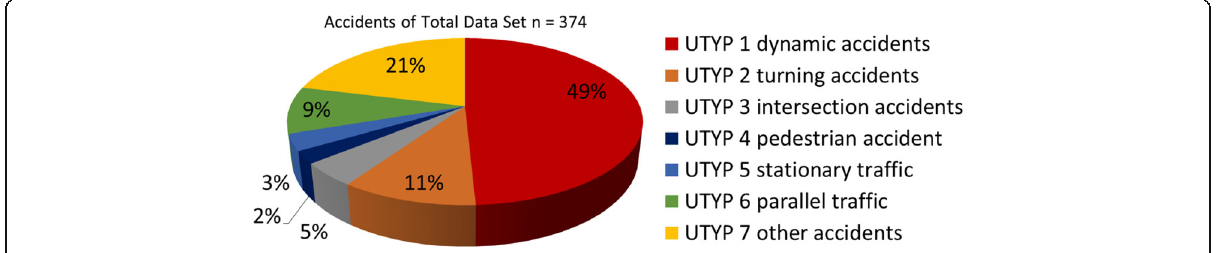
Fig. 12 Distribution of accident types (UTYP 1xx-7xx) with difficult weather conditions